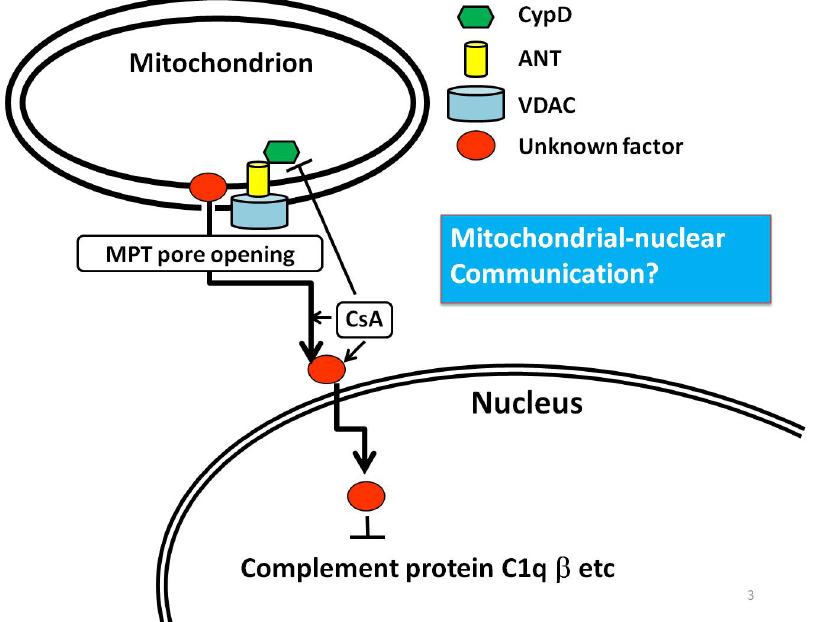
Figure 1. A model of signaling pathways includes hypothetic transcriptional factor (red ellipse) downstream from CypD (green hexagon). Mitochondria have a special protein pore that is formed in the membranes under certain pathological conditions, such as traumatic brain injury and stroke. This pore is the mitochondrial membrane permeability transition pore, or MPT pore. CypD is a modulator of this pore. VDAC (voltage-dependent anion channel) (blue cylinder) and ANT (adenosine nucleotide translocase) (yellow cylinder) are main components that constitute the MPT pore. An unknown factor resides in mitochondria and detects the MPT pore opening regulated by CypD. This factor then translocates from mitochondria to the nucleus and affects transcriptional